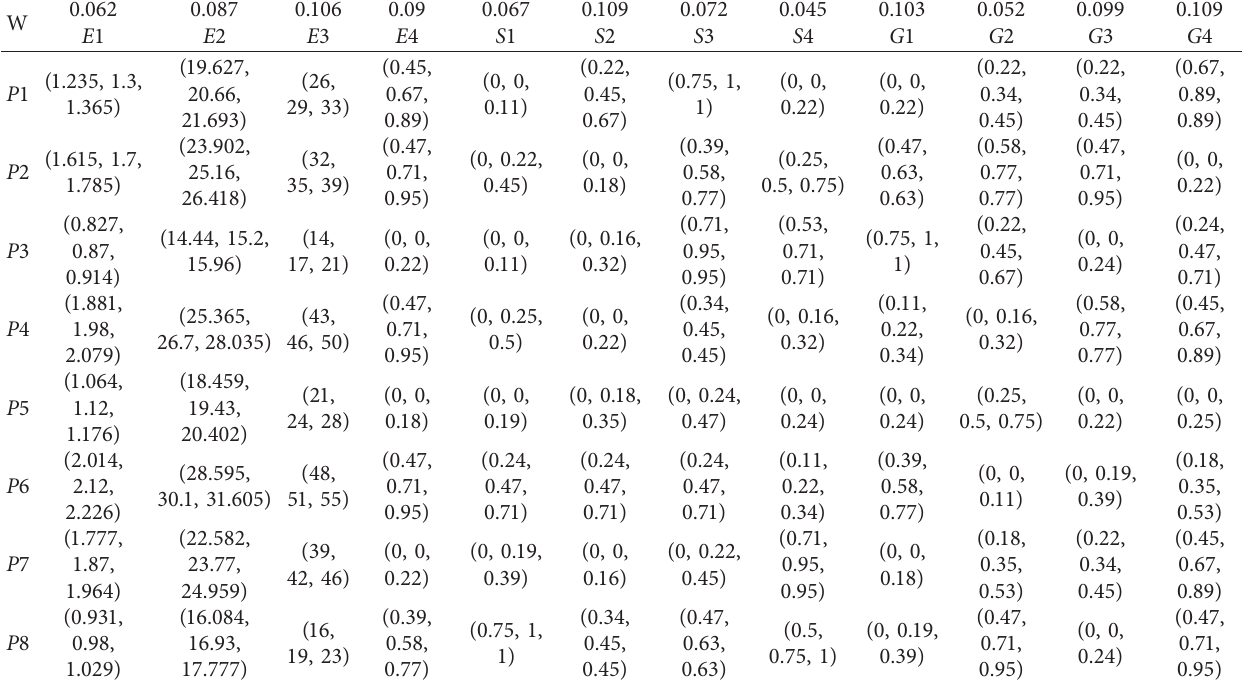
Table 12: Quantitated linguistic scoring matrix of sustainability criteria by considering probability for proposed projects. W